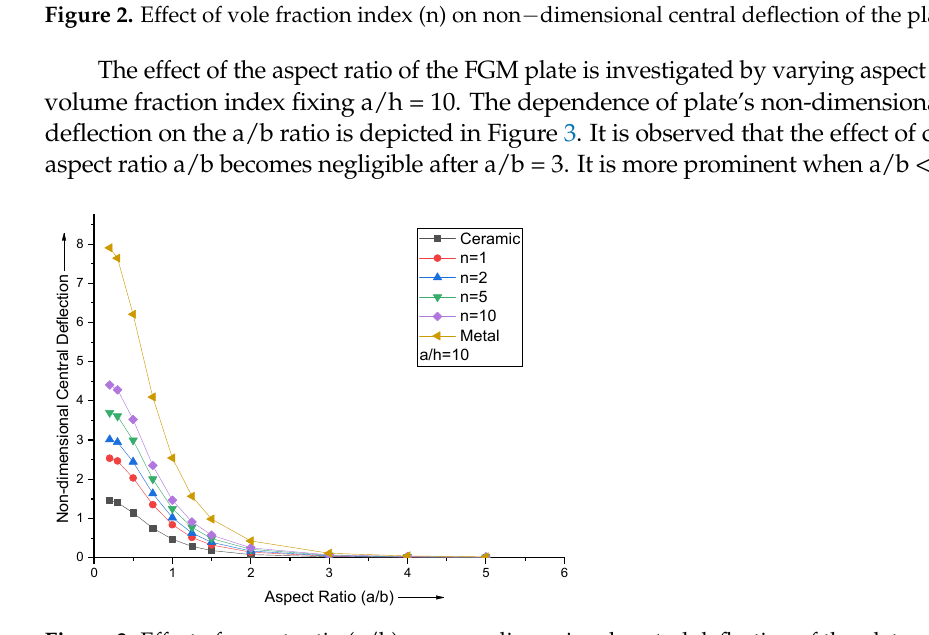
Figure 3. Effect of aspect ratio (a/b) on non − dimensional central deflection of the plate. For various values of the volume fraction index, the effect of changing the side-to-thickness ratio (a/h) on the non-dimensional central deflection for a square simply supported FGM plate is shown in Figure 4. After a/h = 10, it is observed that the non-dimensional centroidal displacement curves follow a parallel line pattern. When the volume fraction index is varied, the non-dimensional normal stress curves attain the extremum near the top and bottom surfaces of the FGM plate, as shown in Figure 5. The neutral axis plane shifts towards the top metallic portion for lower values of n and then comes back to midplane for higher n values. When the aspect ratio is varied, the extremum of non-dimensional normal stress at the top and bottom surfaces of the FGM plate decreases with the increase in aspect ratio. The non-dimensional normal stress curves attain zero at Z = 0.075 for all aspect ratios of the FGM plate with n = 2, as shown in Figure 6. The increase in the side-to-thickness ratio (a/h) leads to an increase in the maximum normal stress value. For all the values of the side-to-thickness ratio with n = 2, non- dimensional normal stress curves attain zero at Z = 0.075, as shown in Figure